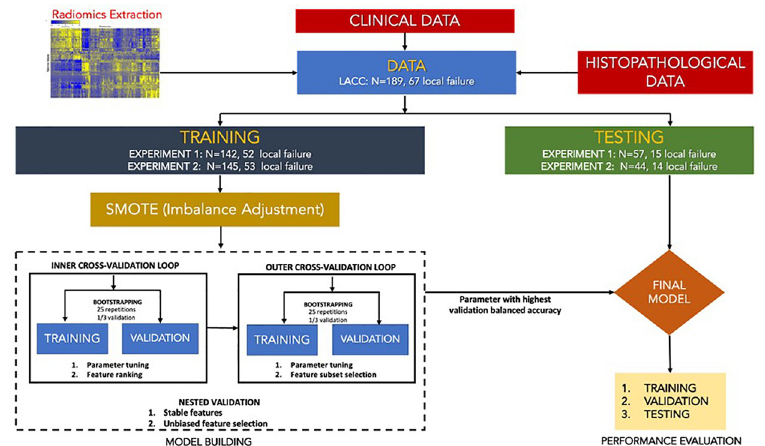
Fig 2. Overall workflow for the analysis in LACC